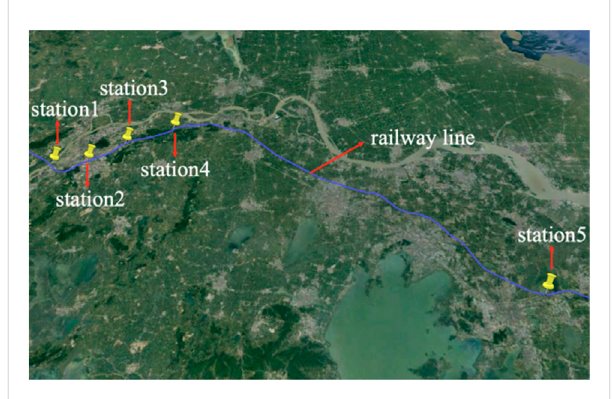
FIGURE 1 Geographical location distribution of the fi ve